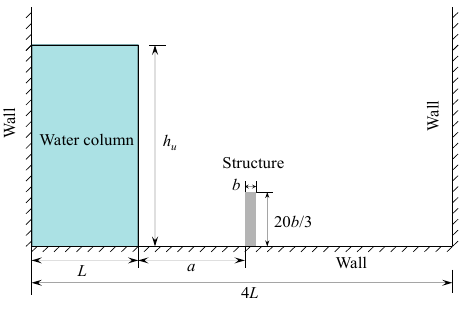
Figure 2. Initial setup of the computational domain.